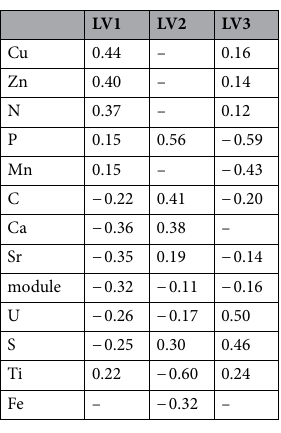
Table 4. Matrix P